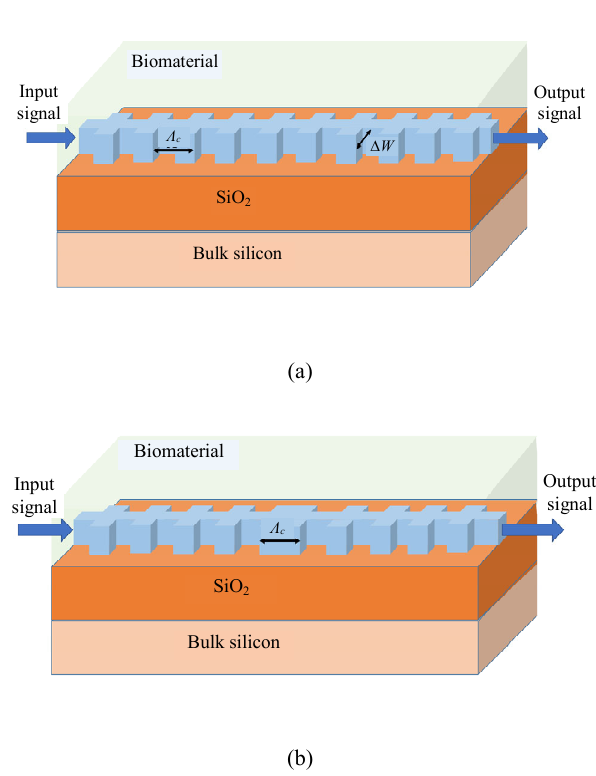
Fig. 2 Schematic of the Bragg-grating device: (a) without cavity and (b) with cavity ( Λ c